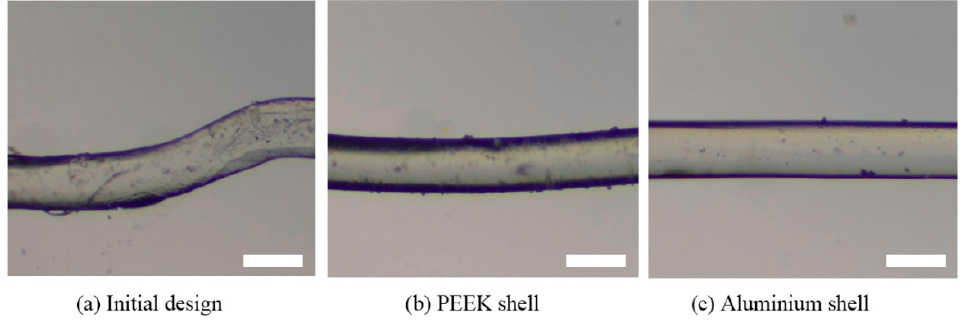
Figure 10. Print samples at the target temperature of 100 °C. Scale bar: 100 μ m.